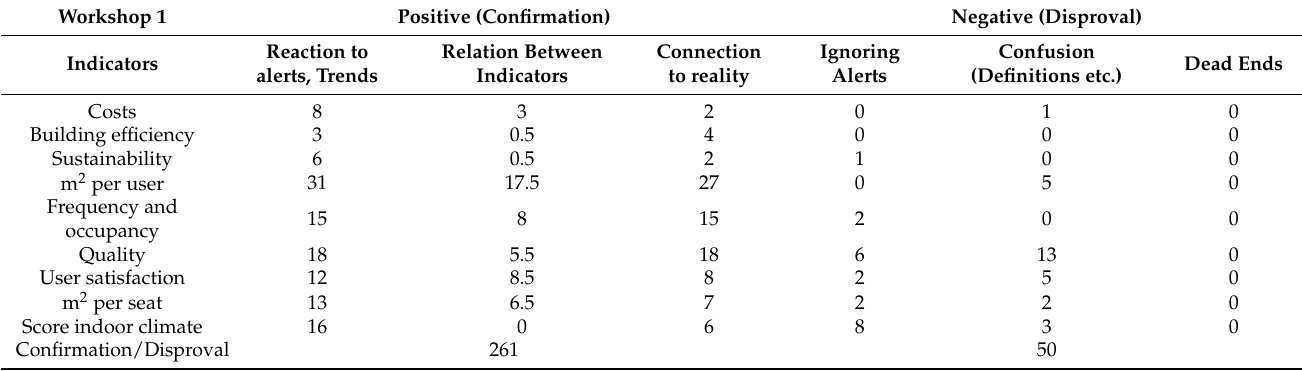
Table A3. Positive and negative interactions of users with the dashboard in workshop 1 (TU Delft).